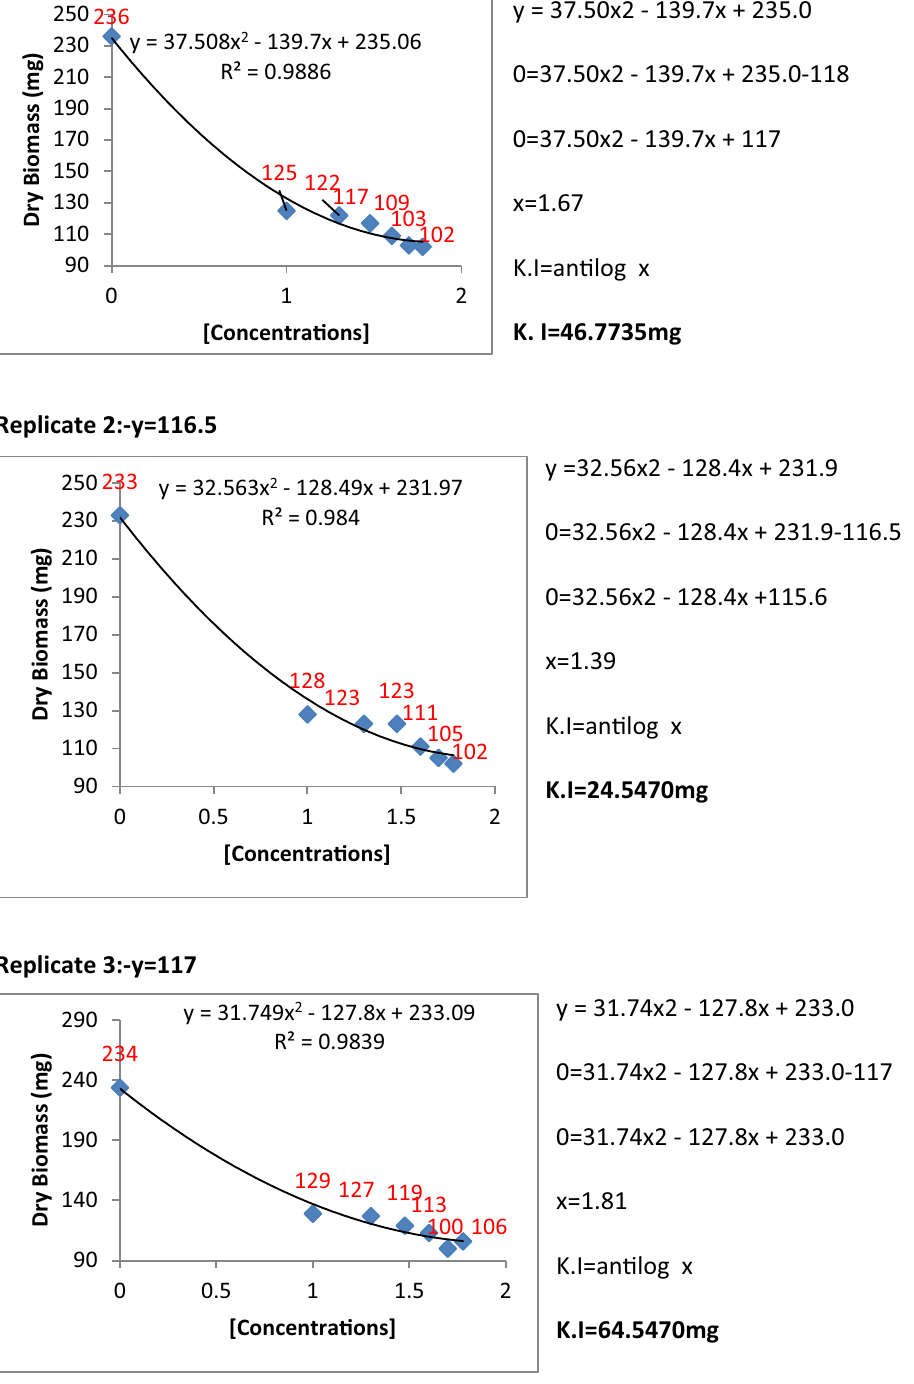
Figure 12. Kinetic constants of inhibition of P. herbarum by metabolites of P. digitatum (3